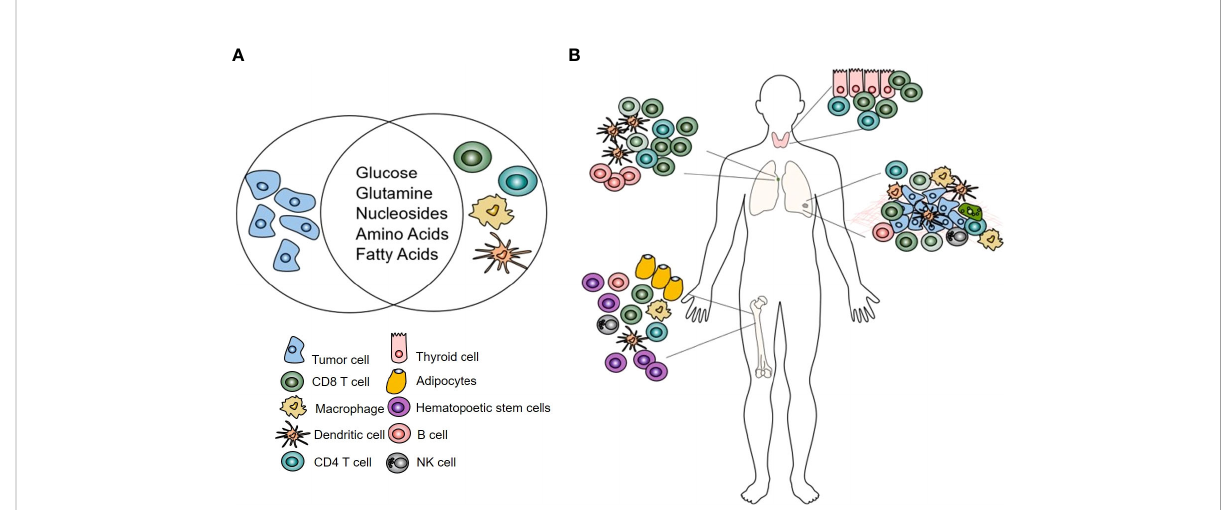
FIGURE 1 (A) Highly proliferating tumor and immune cells share metabolic needs. (B) The effects of immunotherapy on immune cells using metabolic tracers can be assessed in the tumor microenvironment but also at sites where no metabolic competition with tumor cells exists: the bone marrow, lymph node,